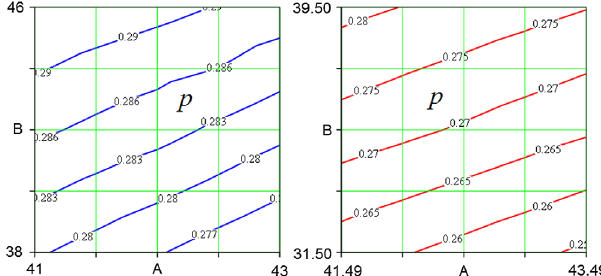
FIG. 15. Parameter p for the TESLA cavity, original (left) and optimized, in the same coordinates as in Figs. 8 and